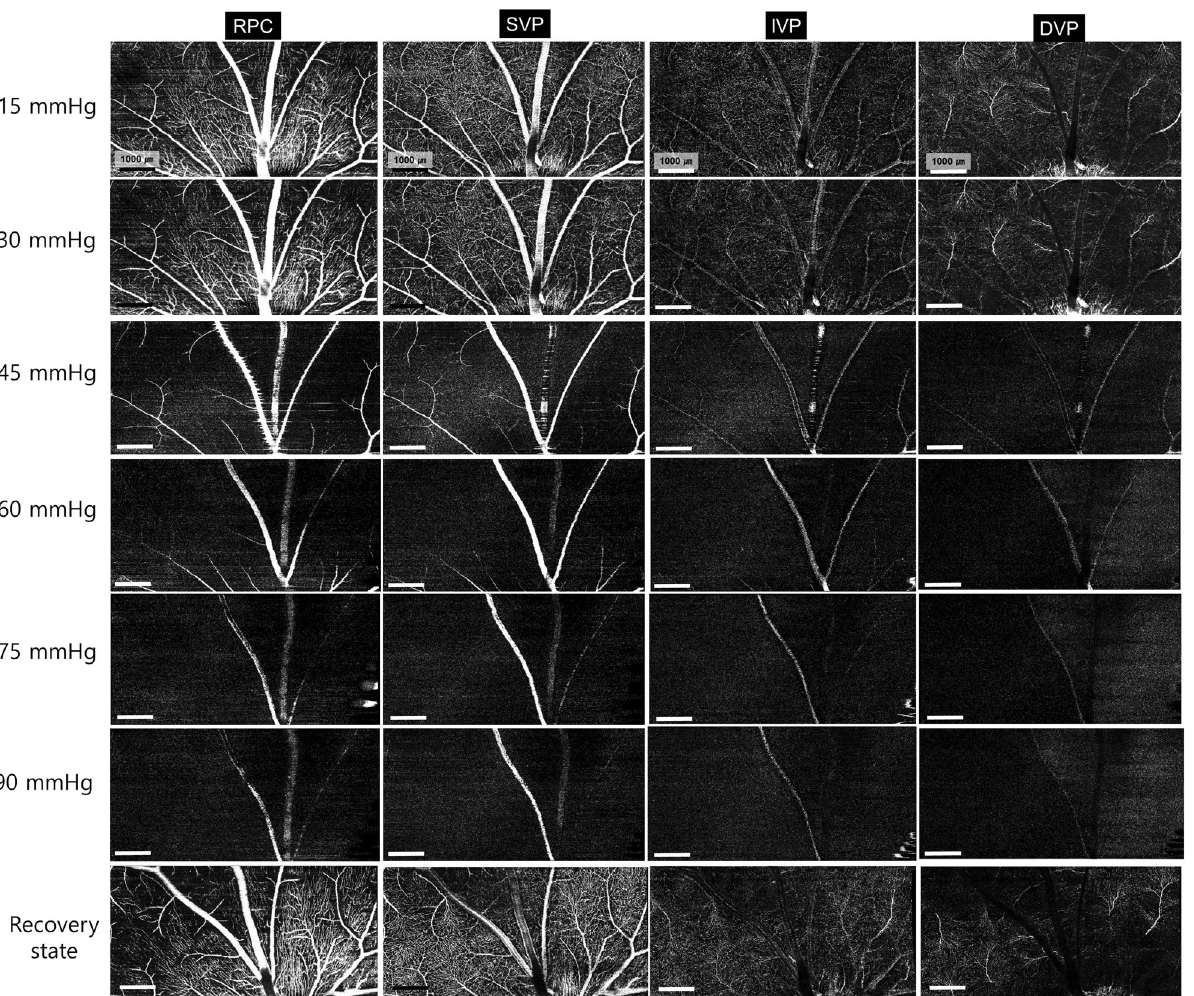
Figure 3. Changes in each retinal and choroidal vascular layer according to changes in IOP from 15 to 90 mmHg, and the recovery state. Retinal capillary attenuation was found at 30 mmHg of IOP. At 45 mmHg, arterioles and venules were observed, but capillary perfusion significantly diminished. In the recovery state, all the retinal capillary layers seemed to have similar signal intensity to baseline. All scale bars indicate 1000